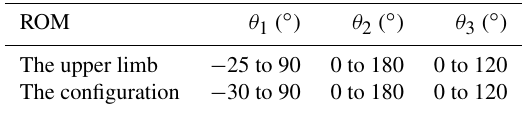
Table 5. The angle of the exoskeleton joints. ROM θ 1 ( ◦ ) θ 2 ( ◦ ) θ 3 ( ◦ ) The upper limb − 25 to 90 0 to 180 0 to 120 The configuration − 30 to 90 0 to 180 0 to